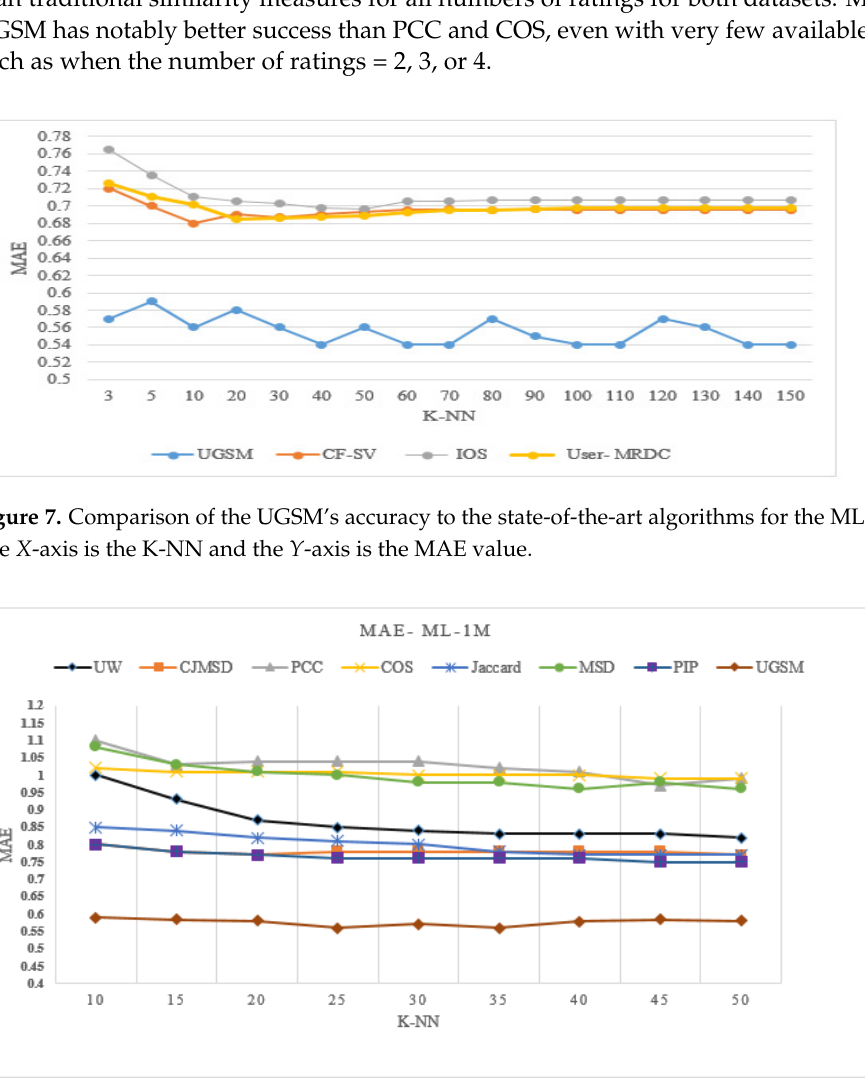
Figure 8. MAE of the UGSM and the state-of-the-art studies for ML-1M dataset. The X -axis is the K-NN and the Y -axis is the MAE value. The results in Figure 8 show that the UGSM model outperforms the mentioned algorithms at all neighbor sizes. Unlike other methods, the UGSM is not affected much when increasing neighbor sizea, as it is almost stable with different neighbor sizes. When k = 50, most of the tested algorithms have improved accuracy. However, the UGSM accuracy is still the best; the prediction accuracy was improved by 24% against the UW method, 17% against the PIP method, and more than that against PCC and